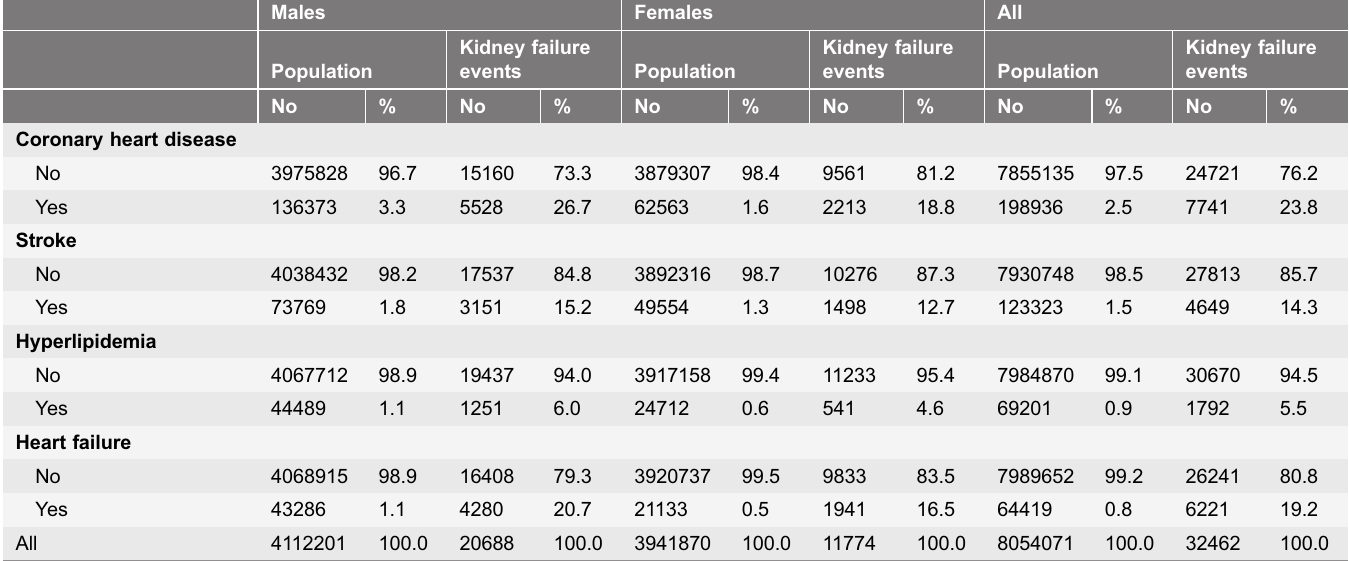
that family history (sibling/parent) of acute kidney failure is a risk factor for both (Table 2). Family history of unspecified kidney failure (sibling/parent) was a risk factor for chronic kidney failure (SIR 5 1.31) (Table 2). Family history of all kidney failure was a risk factor for all types of kidney failure (Table 2). Familial risks of kidney failure were determined in both males and females. There were no major sex differences (Table 2). In Table 3, familial concordant risks are presented according to the affected relative. Familial risks were adjusted for age, sex, time period, region of residence, socioeconomic status, and comorbidities. Sibling history of chronic kidney failure showed the highest familial risk, with a concordant SIR of 2.52. The familial concordant risk for individuals with a parental history of chronic kidney failure was 1.67. There were no major sex differences. The familial concordant risks for acute and unspecified kidney failure were not significant (Table 3). The familial concordant risks (parent/sibling history) were stratified according to age at diagnosis (Table 4). The familial risks for chronic kidney failure were highly age dependent and were highest risks at younger ages (SIR 5 6.33 between the age of 10 and 19 years). Increased concordant familial risk of 1.81 was noted also for chronic kidney failure for those aged 60 years or more (Table 4). The familial concordant risks for chronic kidney failure were increased in all age groups except those younger than 10 years. For acute kidney failure, the familial concordant risks were only significantly increased only in two age groups (Table 4). The familial risk for acute kidney failure before age of 10 years was high (SIR 5 14.21). The age of these six children with familial acute kidney failure